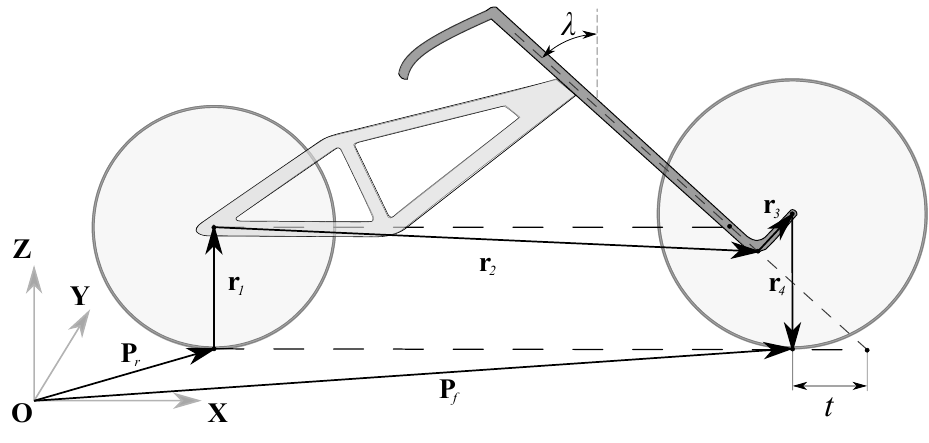
Figure 4. Kinematic chain of the two-wheeled vehicle